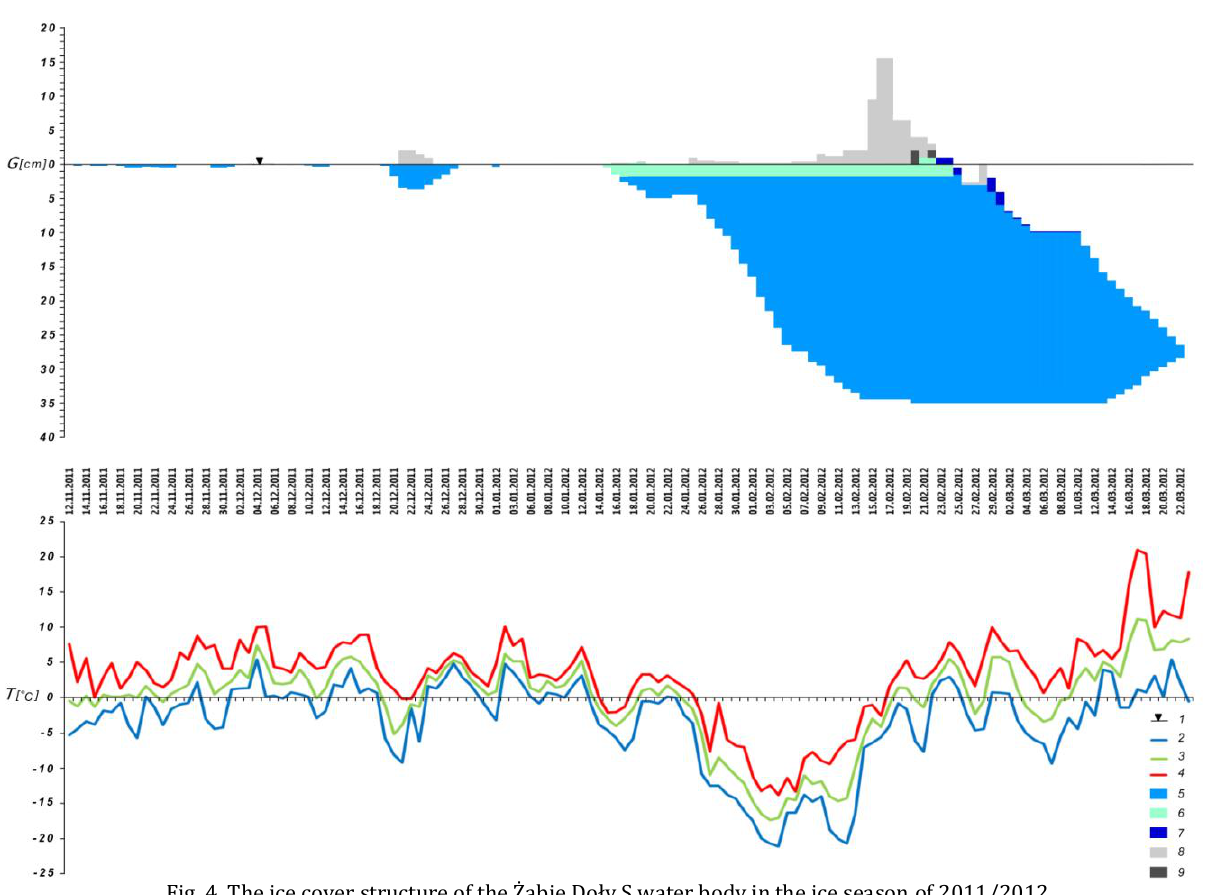
Fig. 4. The ice cover structure of the Żabie Doły S water body in the ice season of 2011/2012 1 – height of the upper part of the ice at the beginning stage, 2 – minimum daily air temperature, 3 – average daily air temperature, 4 – maximum daily air temperature, 5 – crystal ice, 6 – snow ice, 7 – water, 8 – snow, 9 –